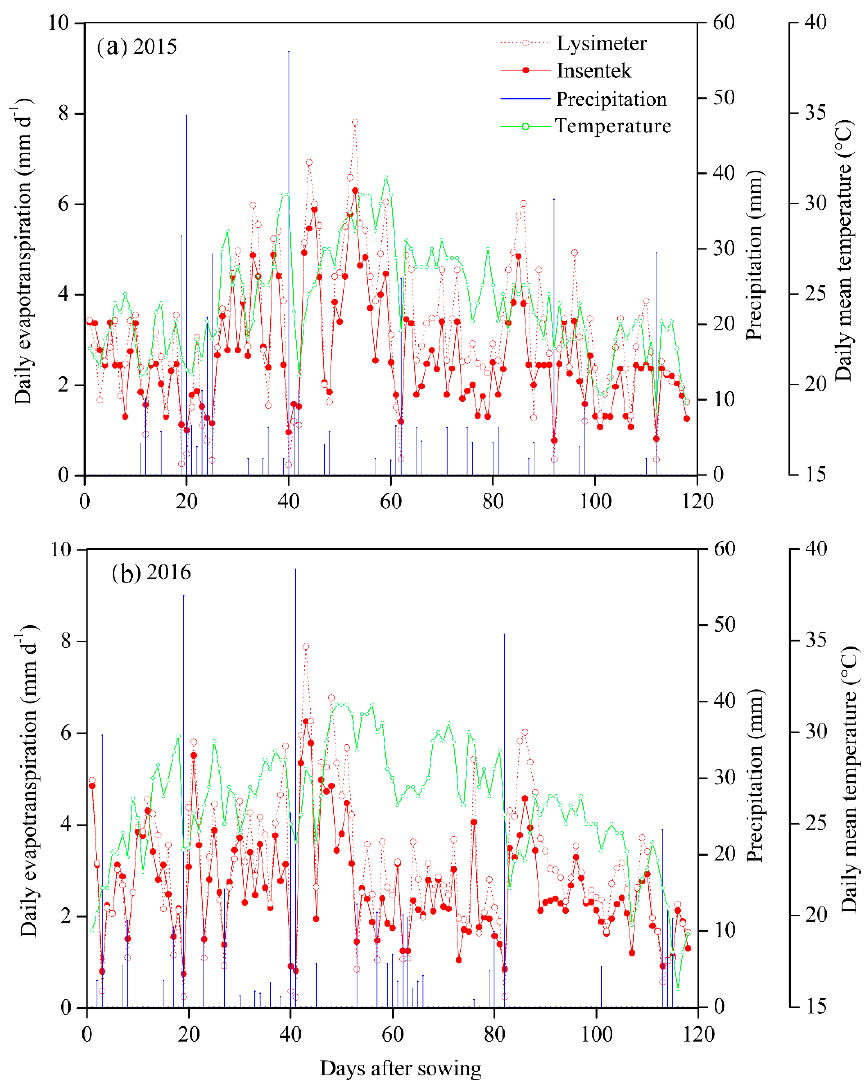
Figure 5. Daily evapotranspiration, air temperature, and precipitation during maize growing seasons of ( a ) 2015 and ( b ) 2016, at the Xuchang Irrigation Experiment Station, in the North China Plain. Vertical drop lines represent precipitation and solid green lines stand for temperature.